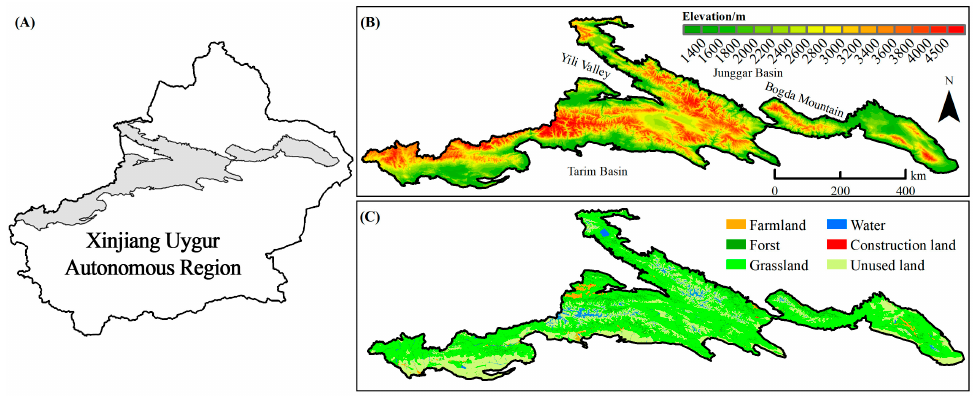
Figure 2. Location of the study area ( A ), the elevation map ( B ), and the land-use map in 2020 ( C ) (map number: Xin S (2021)